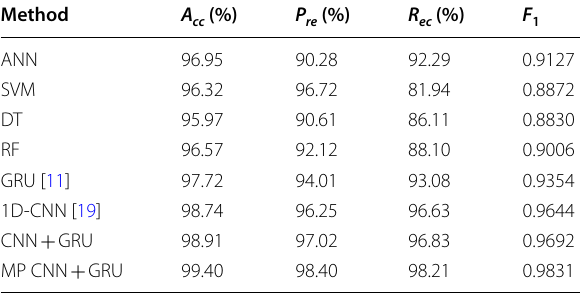
Table 4 TSA result of a single sample on the IEEE 39-bus system